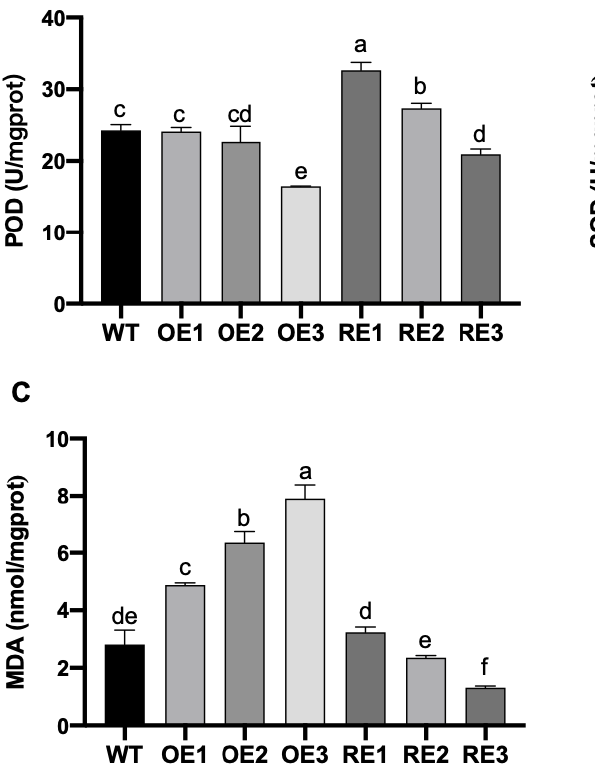
Figure 6. The difference of physiological indexes among poplar transgenic lines under NaHCO 3 stress. ( A ) SOD activity of transgenic lines. ( B ) SOD activity of transgenic lines. ( C ) MDA content of different transgenic lines. The means and standard errors were calculated with three replications ( p < 0.05). Multiple comparison was used via Duncan test. Different letters indicate significant differ- ences.